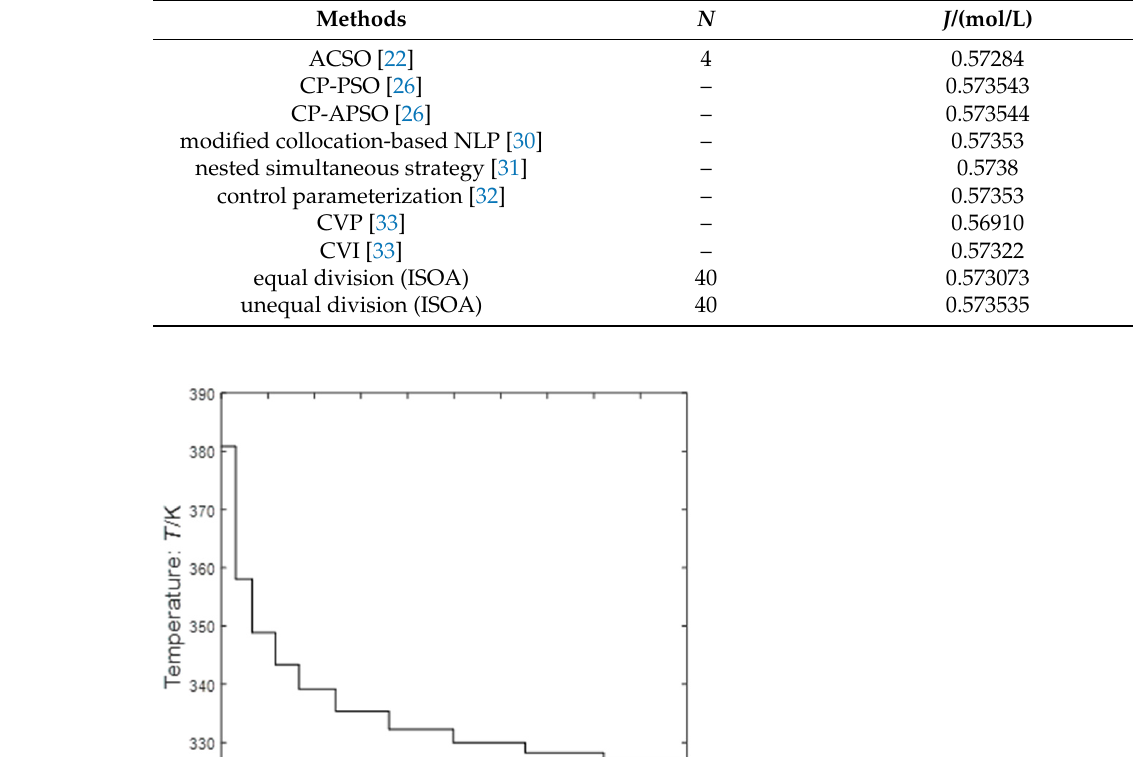
Table 3. Comparison of methods for parallel reaction problems in tubular reactors.